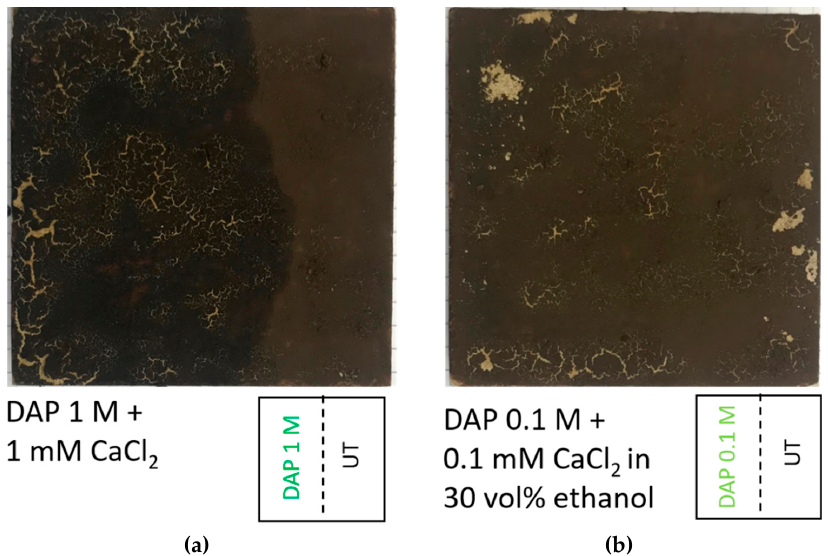
Figure 3. Alteration of the specimen surface caused by consolidant application 30 min after guano application: 1 M DAP + 1 mM CaCl 2 ( a ) and 0.1 M DAP + 0.1 mM CaCl 2 in 30 vol.% ( b ). application: 1 M DAP + 1 mM CaCl + 0.1 mM CaCl 2 ( a ) and 0.1 M DAP 2 in 30 vol.% ( b